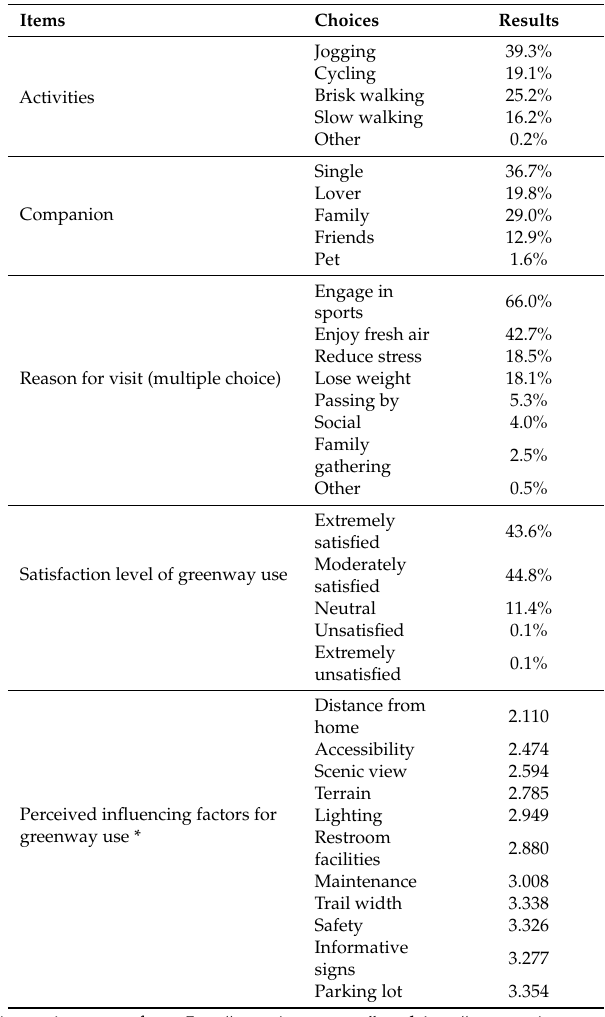
Table 3. Behavior of users in Wutong Greenway.